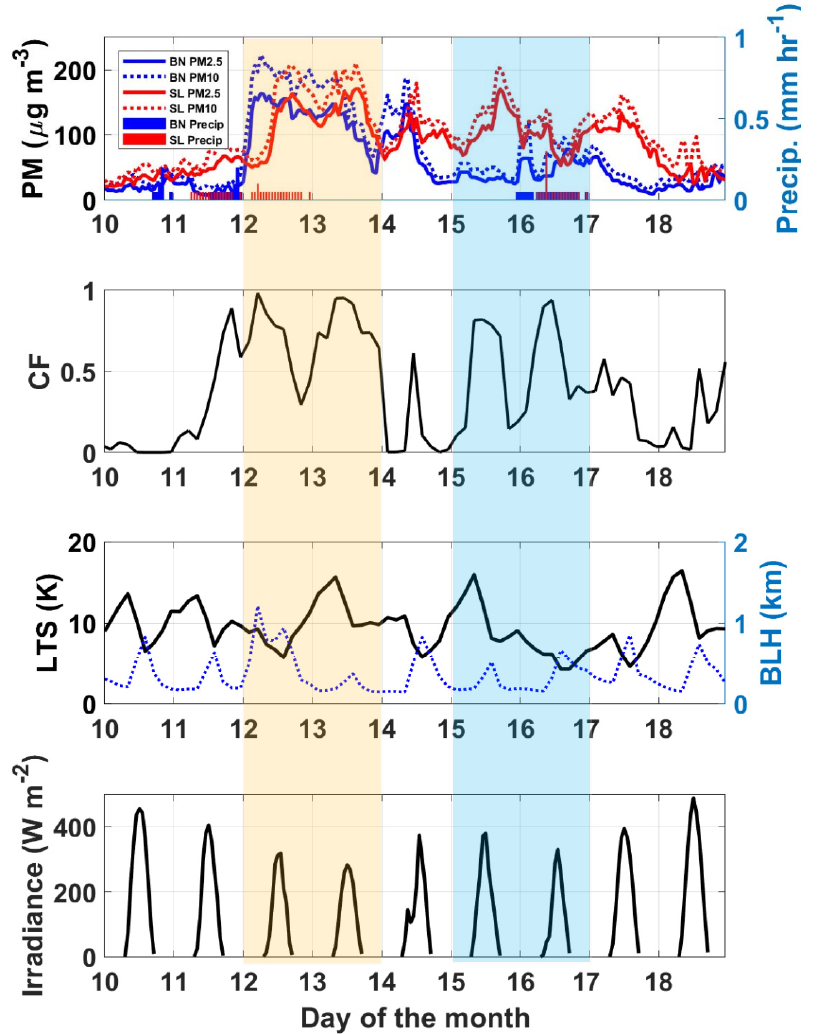
Figure 3. Time series of PM2.5, PM10, hourly precipitation from 10 to 18 January 2013 at Seoul (SL; red) and Baengnyeongdo (BN; blue). Variations of domain-averaged CF, LTS, and BLH from LDAPS, and irradiance observed at Seoul for the same period. Orange and blue shadings indicate the first and second periods, respectively.